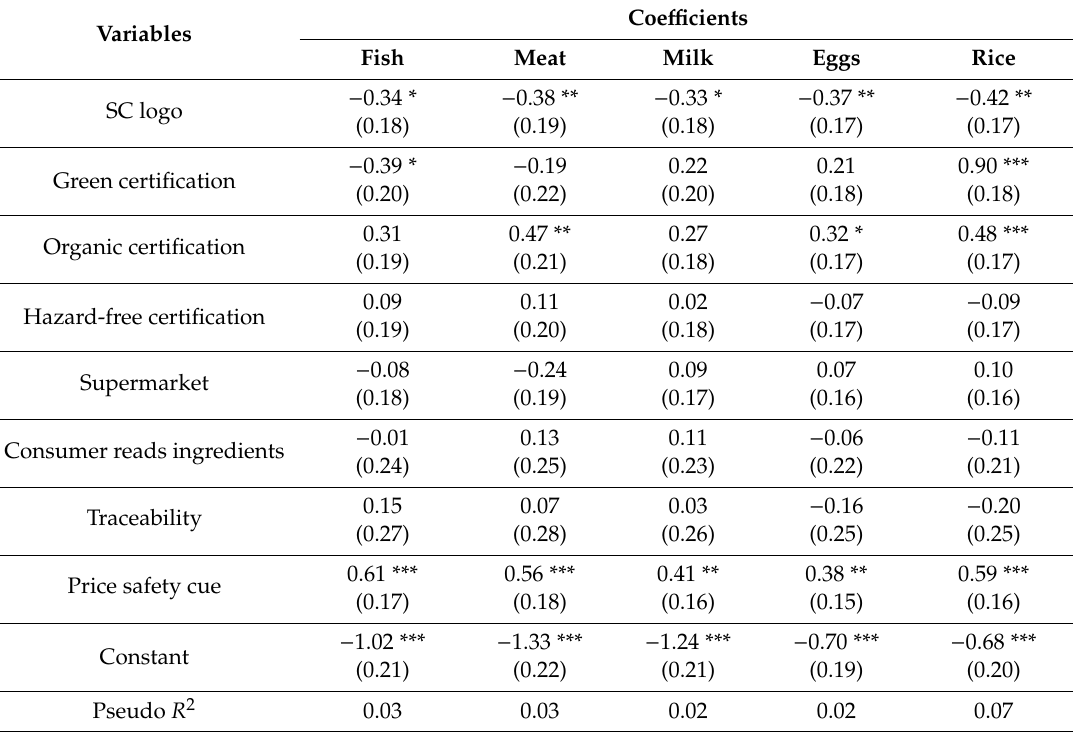
Table 3. Influence of brands on the food categories